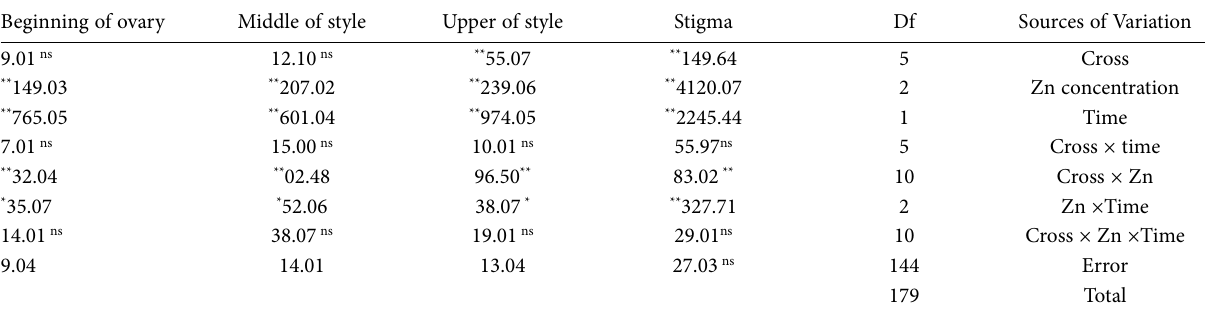
Table 1. Analysis of variance of the effect of time, crosses and Zn on the pollen germination on the stigma and tube penetration to upper and middle part of the style and so beginning of the